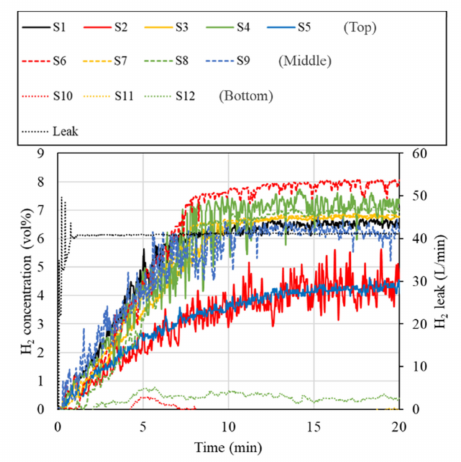
Figure 4. Hydrogen concentration variation by leak (Case 13: hydrogen supply pressure 3 kPa, leak hole 1/8 inch, leak amount 40 L/min, no vent opening, and 1/3 operational